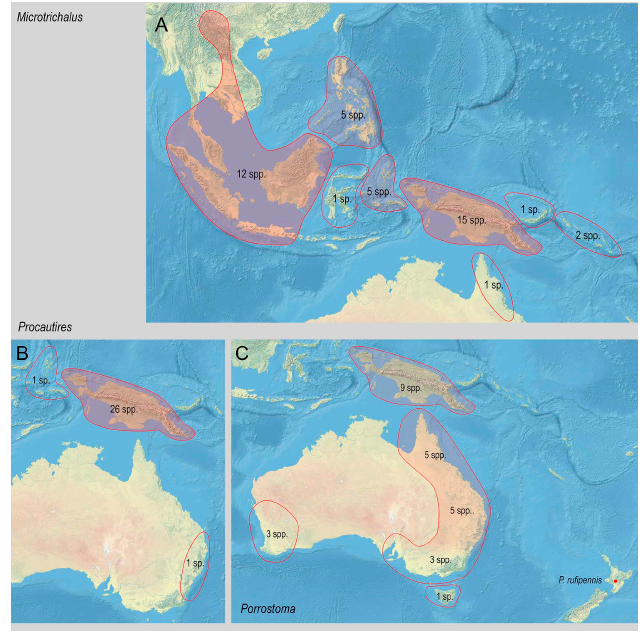
Figure 6. Distribution and diversity of Metriorrhynchina genera. ( A ) Microtrichalus Pic, 1921; ( B ) Procautires Kleine, 1926; ( C ) Porrostoma Laporte, 1838.